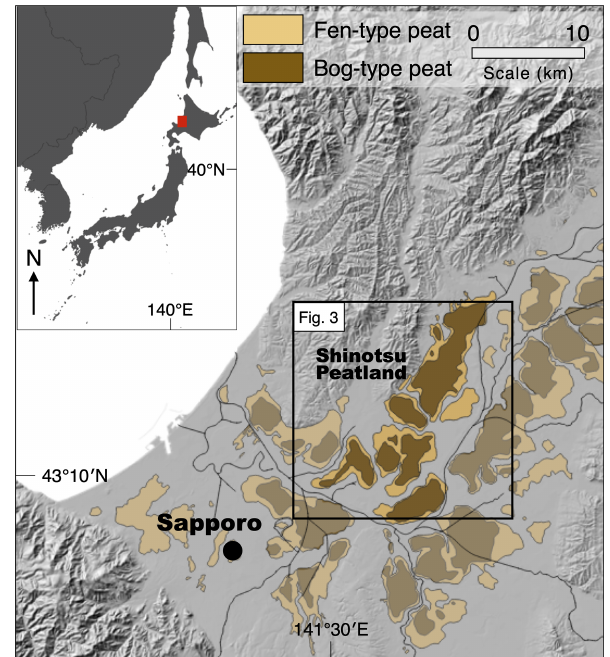
Figure 1. Location and extent of the study site and peatland area in Shinotsu, Hokkaido. The background shaded-relief map is obtained from Geospatial Information Authority of Japan. The distribution of peat is based on Hokkaido Agricultural Reserch Institution (1954). An inset map in the upper left corner shows the location of the study site within